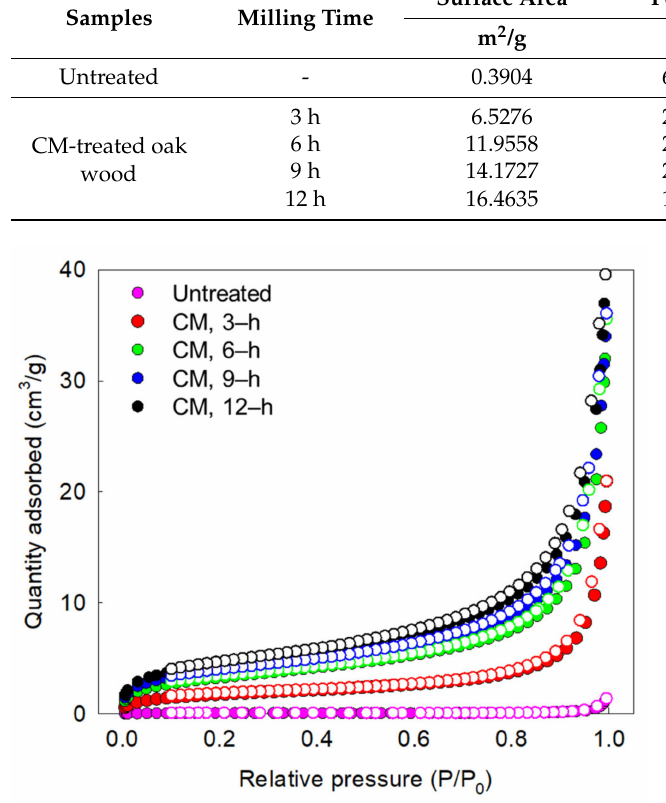
Figure 3. N 2 physisorption isotherms of untreated and CM-treated oak